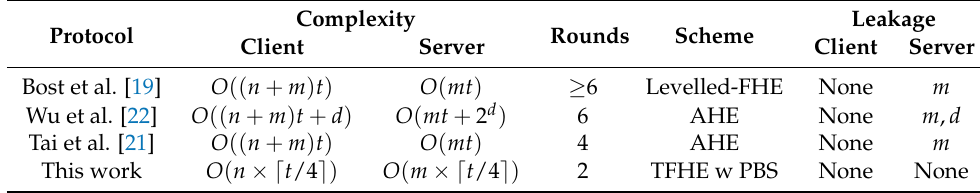
Table 1. Computational complexity